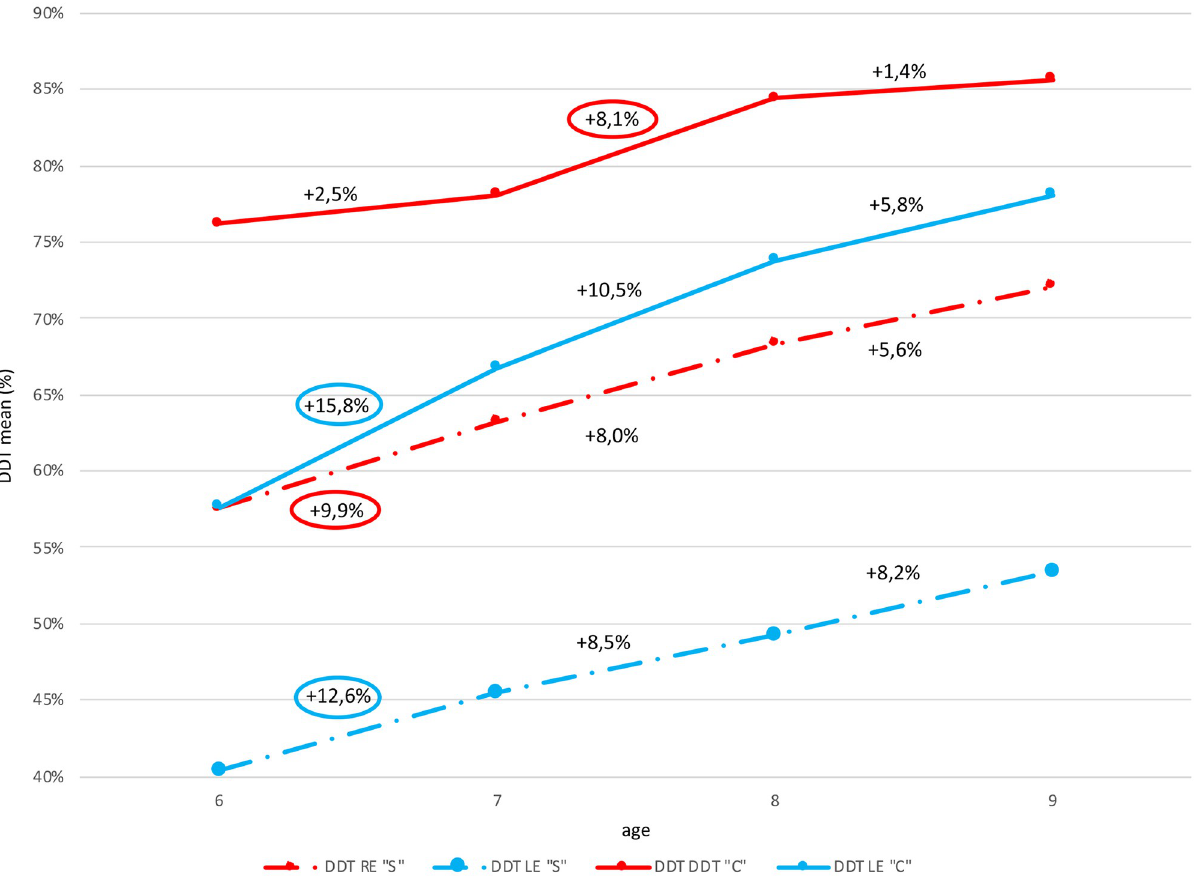
Fig 12. Comparison of dichotic listening development dynamics (mean values of DDT test results for dependent samples), in both study groups, in all age groups.